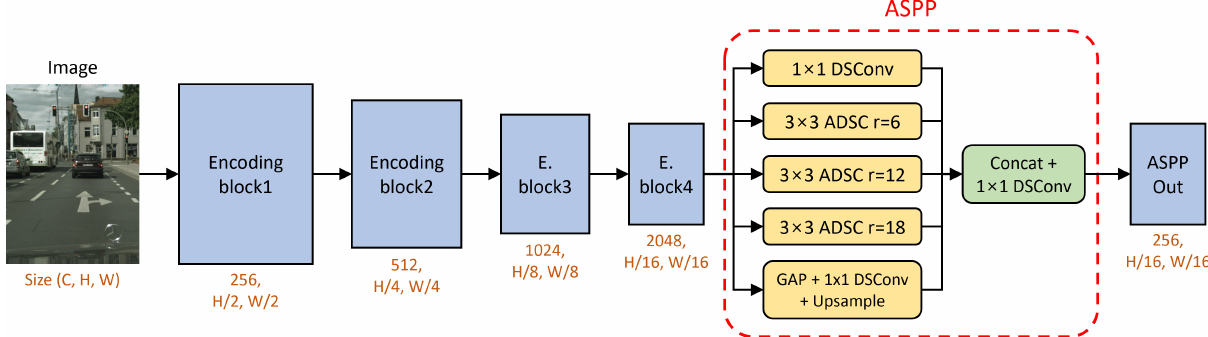
Figure 6. Atrous spatial pyramid pooling diagram. Symbols C , H , W , r indicate the number of channels, height, width, and rate, respectively. ADSC, GAP, and Concat denote depthwise separable convolution with atrous convolution, global average pooling, and concatenation,